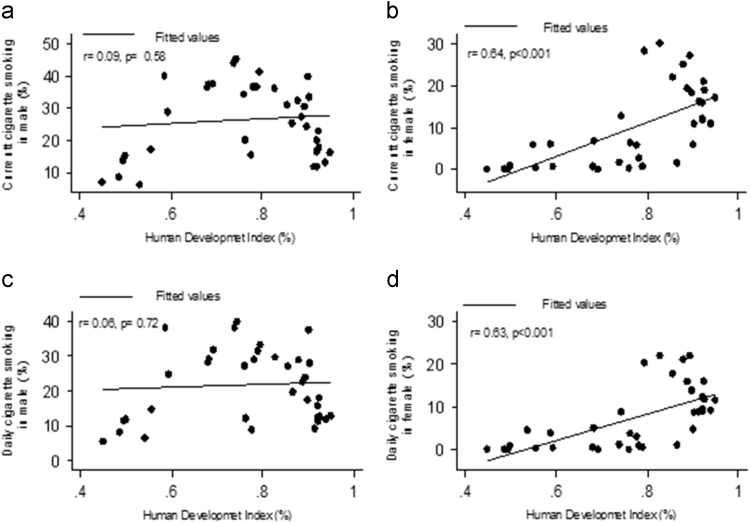
Correlation between HDI and prevalence of cigarette smoking. a: current cigarette smoking in men, b: current cigarette smoking in woman c: daily cigarette smoking in men d: daily cigarette smoking in women.